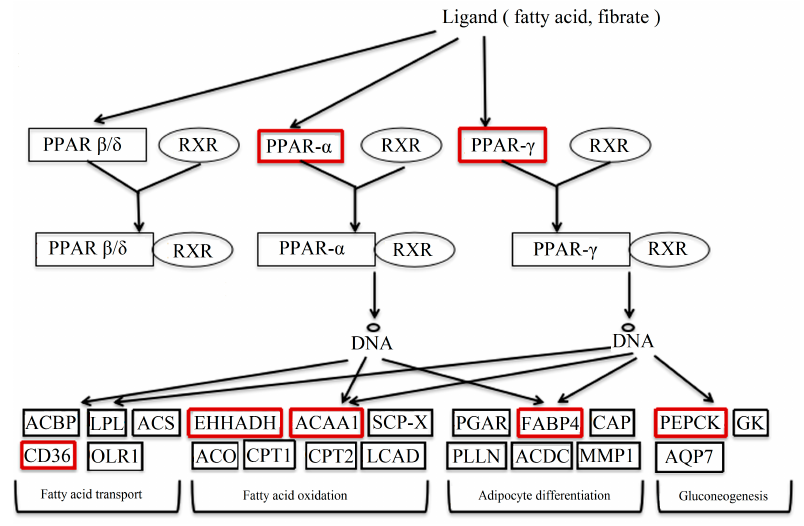
Figure 10. Part of the PPAR signal pathway.